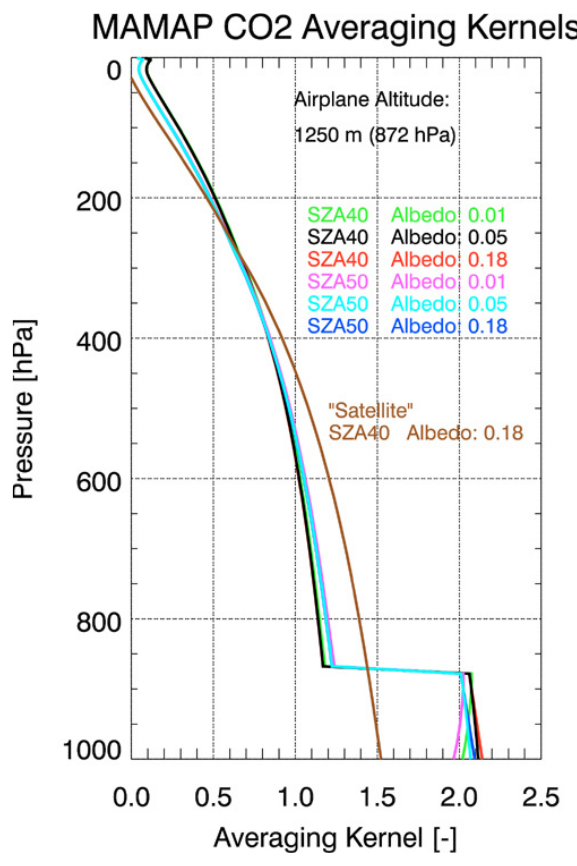
Fig. 1. CO 2 averaging kernels of the MAMAP WFM-DOAS re- trieval for an aircraft altitude of 1250m and different albedos and solar zenith angles. For comparison, averaging kernels for a hypo- thetical aircraft altitude of 1000km (i.e. satellite altitude) are also